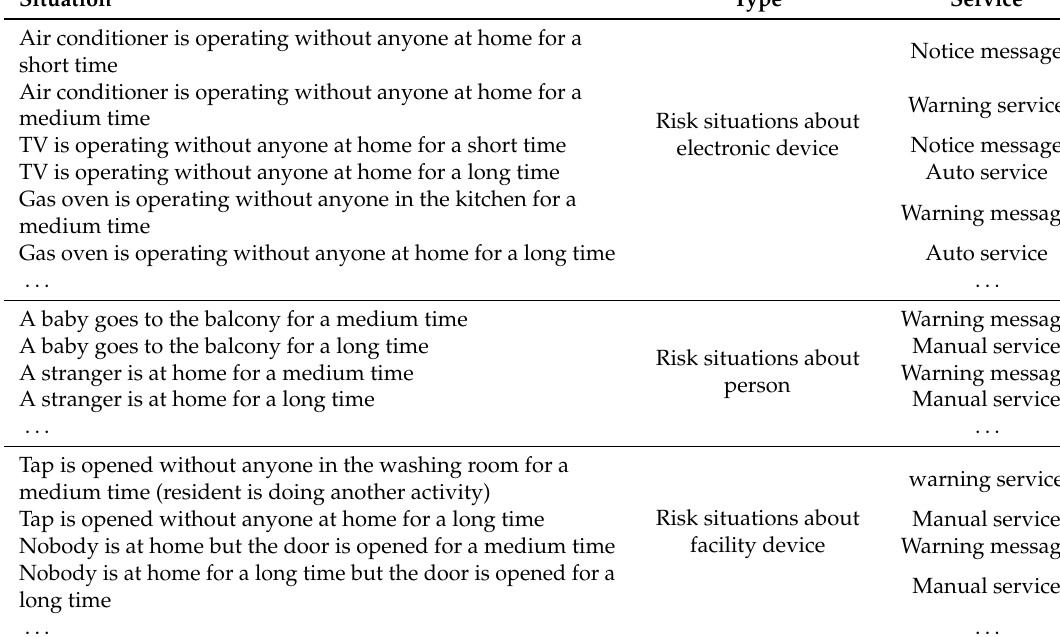
Table 6. Typical simple cases related to home safety.